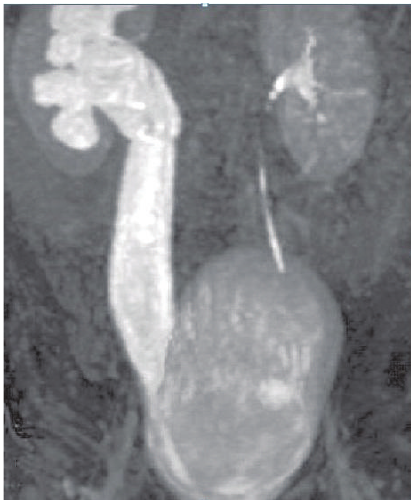
Figure 2: MRU showing a midureteric stricture in crossed ectopic left to right kidney.